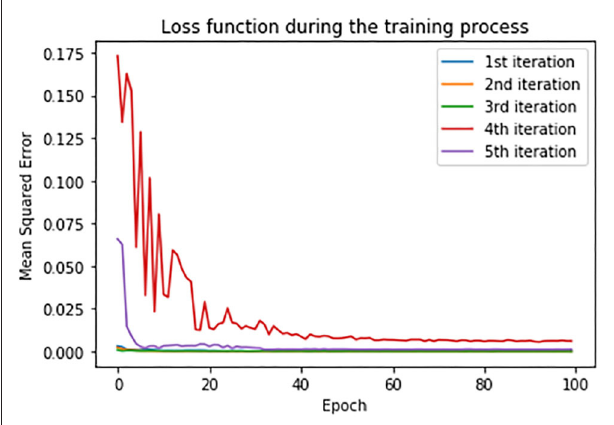
FIGURE 11 | Loss function in training set during the cross-validation process.